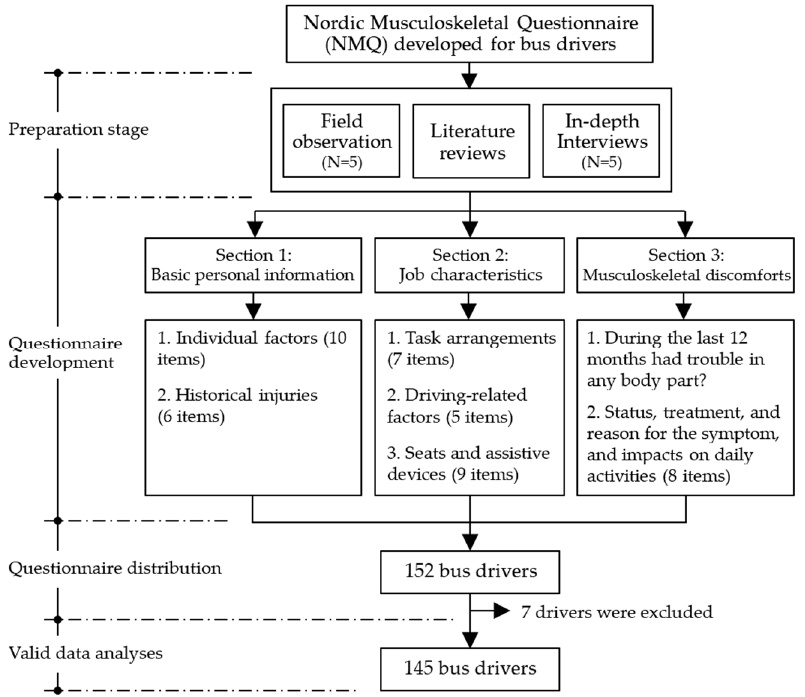
Figure 2. Flowchart of Nordic Musculoskeletal Questionnaire (NMQ) developed in this study.